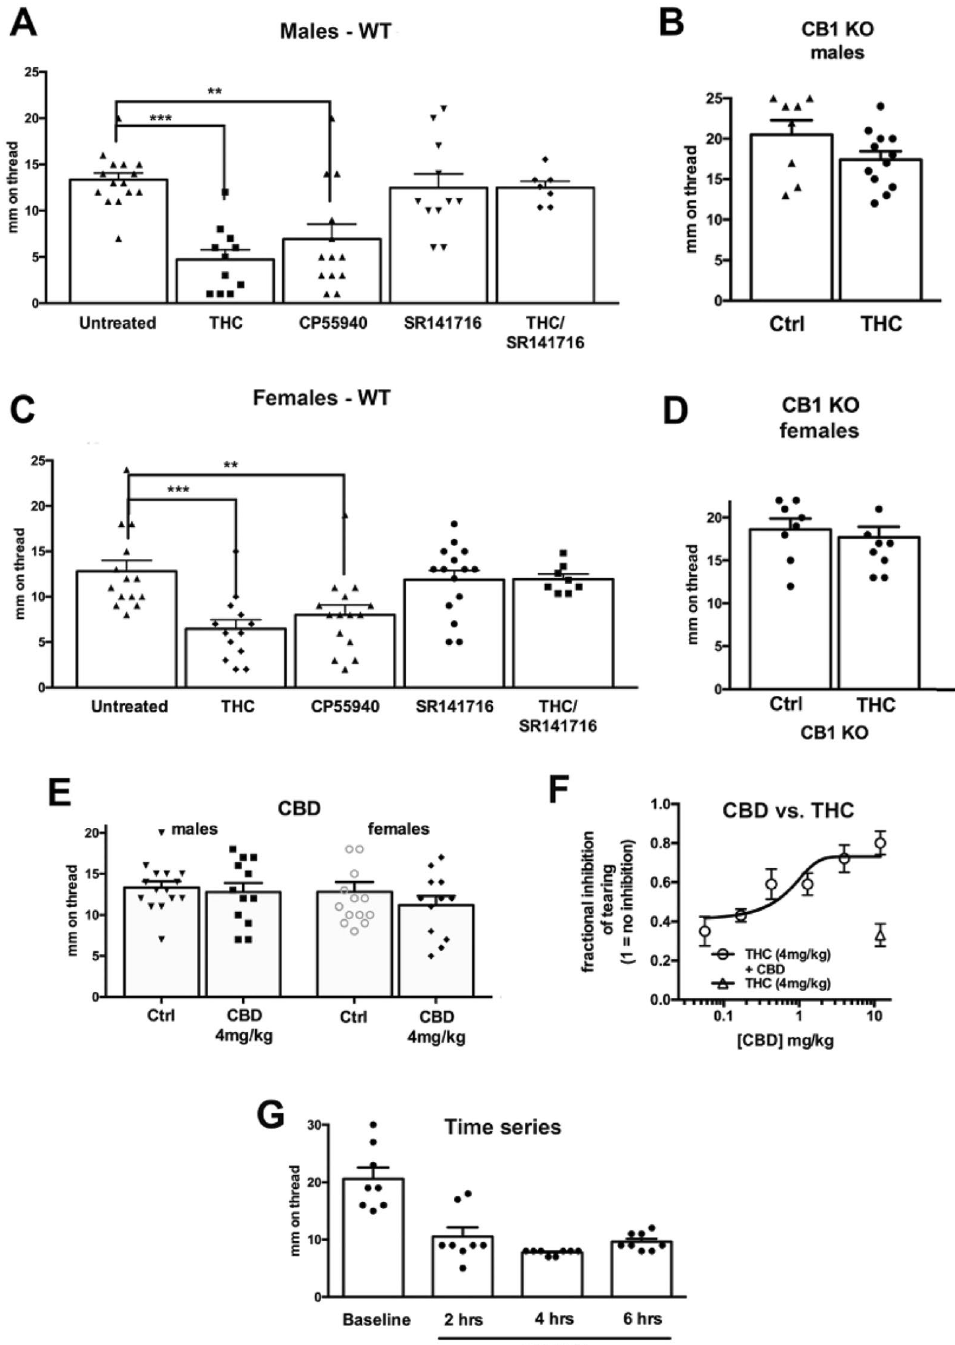
Figure 3. CB1 receptors regulate basal salivation. In male ( A ) and female ( C ) mice, THC (mg/kg, IP) or CP55940 (0.5 mg/kg) reduced basal salivation 1 h after treatment. The CB1 antagonist SR141716 (4 mg/kg) had no effect. ( B , D ) THC had no effect in CB1 knockout males ( B ) or females ( D ). ( E ) CBD (4 mg/kg) had no effect on salivation in males or females. ( F ) CBD reversed the effects of THC in a concentration-dependent manner. ( G ) Effect of CP55940 persists for at least six hours. **p < 0.01; ***p < 0.005, one-way ANOVA with Dunnett’s post-hoc test vs.